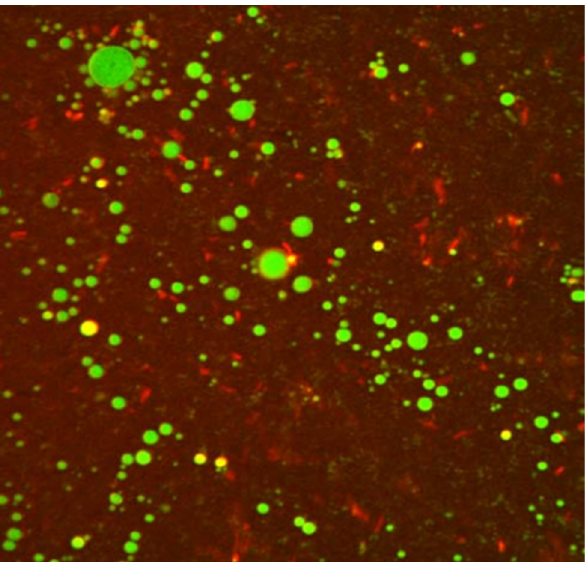
Figure 2. CSLM image of a 10% cottonseed o/w emulsion stabilized by 1% sodium caseinate. (Spherical oil droplets stabilized in the protein network, image size:131 × 131 μ m) (produced in NTUA/Laboratory of Food Chemistry and Technology).